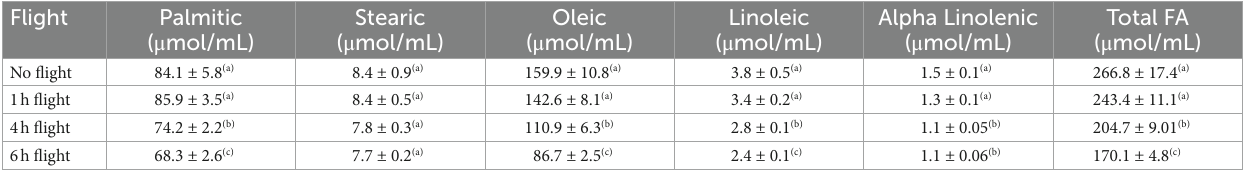
TABLE 2 Change in the concentration of essential and nonessential fatty acids in the fat body of 5-day old true armyworm moths as a function of flight duration under summer